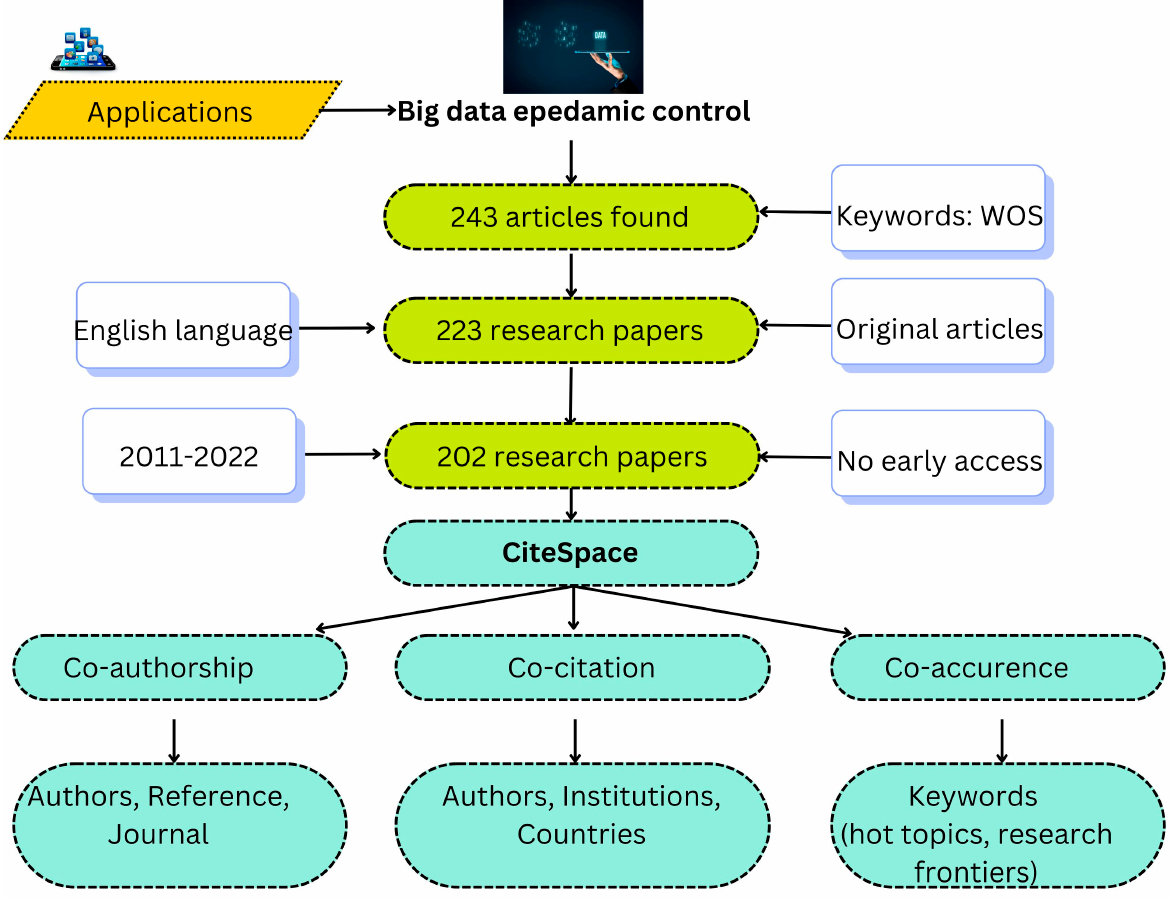
Figure 3. The flowchart displaying the accomplishments for the current Figure 3. The flow c hart displaying the accomplishments for the current study.